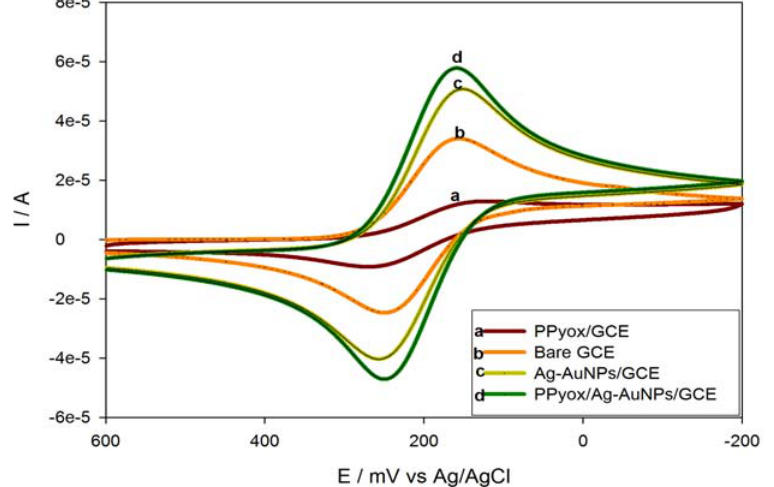
Figure 6 . CVs of PPyox/GCE (curve a ), bare GCE (curve b ), Ag-AuNPs/GCE (curve c ) and PPyox/Ag-AuNPs/GCE (curve d ) in 5 mM K Scan rate: 50 mV s − 1 .